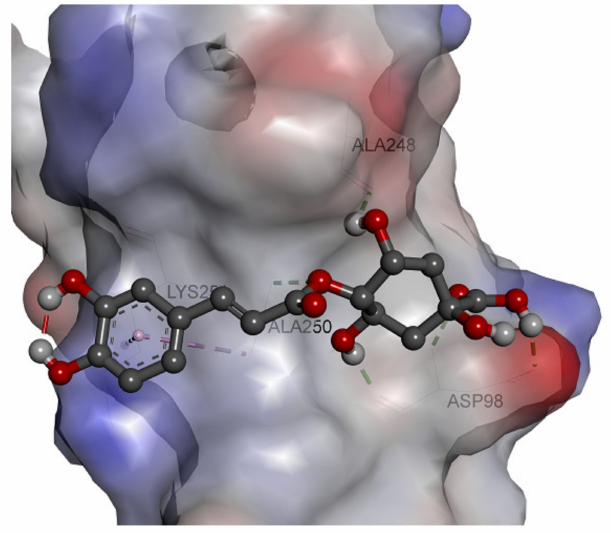
Figure 6. Three-dimensional structure of cryptochlorogenic acid at the active site of ZIKV envelope protein using docking